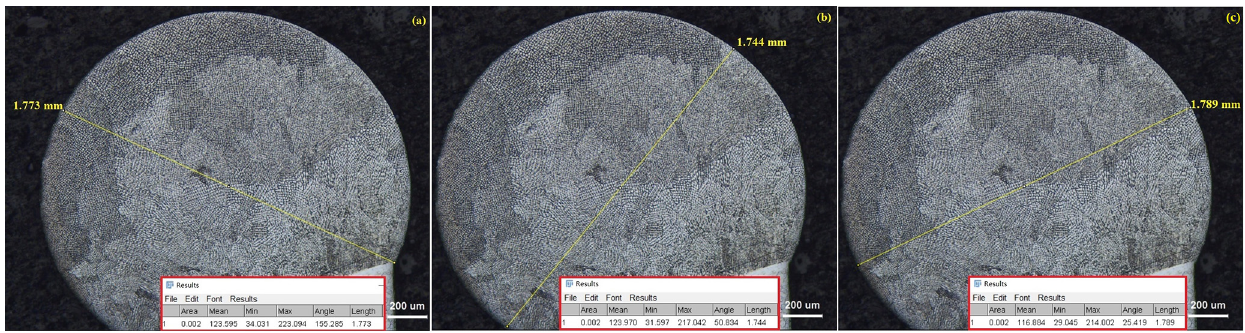
Figure 3. Cross section morphology of additive zone with wire-feeding speed of 8inmin − 1 (3.39mms − 1 ).